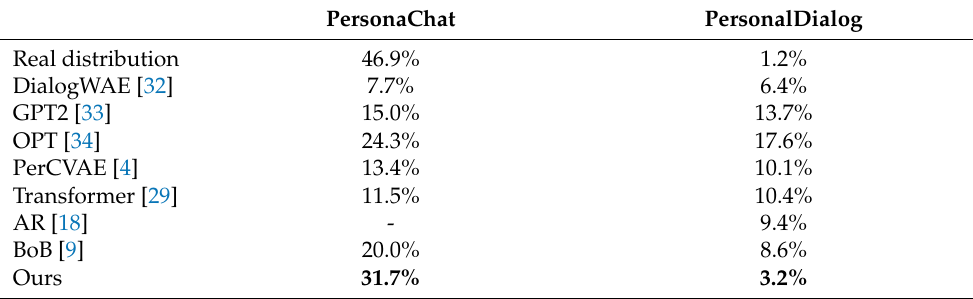
Table 7. Persona distribution of result on PersonaChat and PersonalDialog datasets.